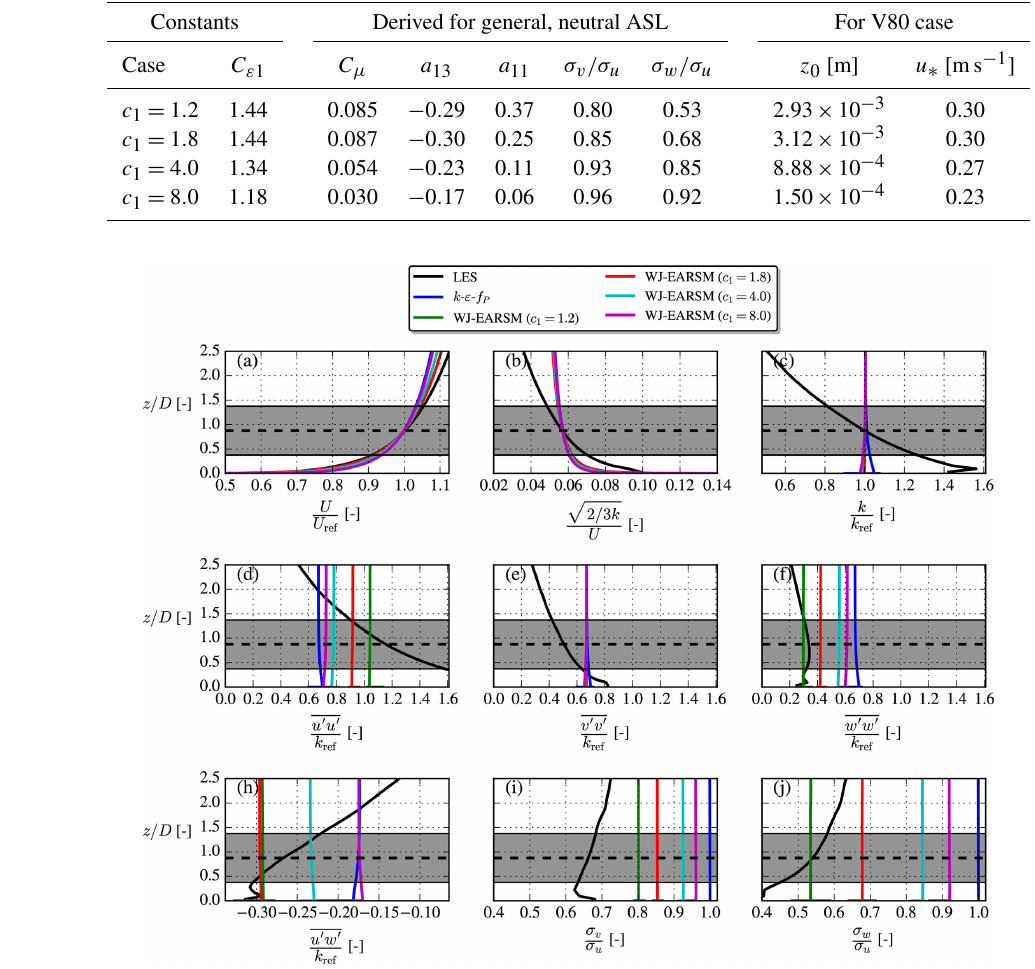
Figure B1. Inflow profiles for the single-wake V80 case with different sets of model constants.